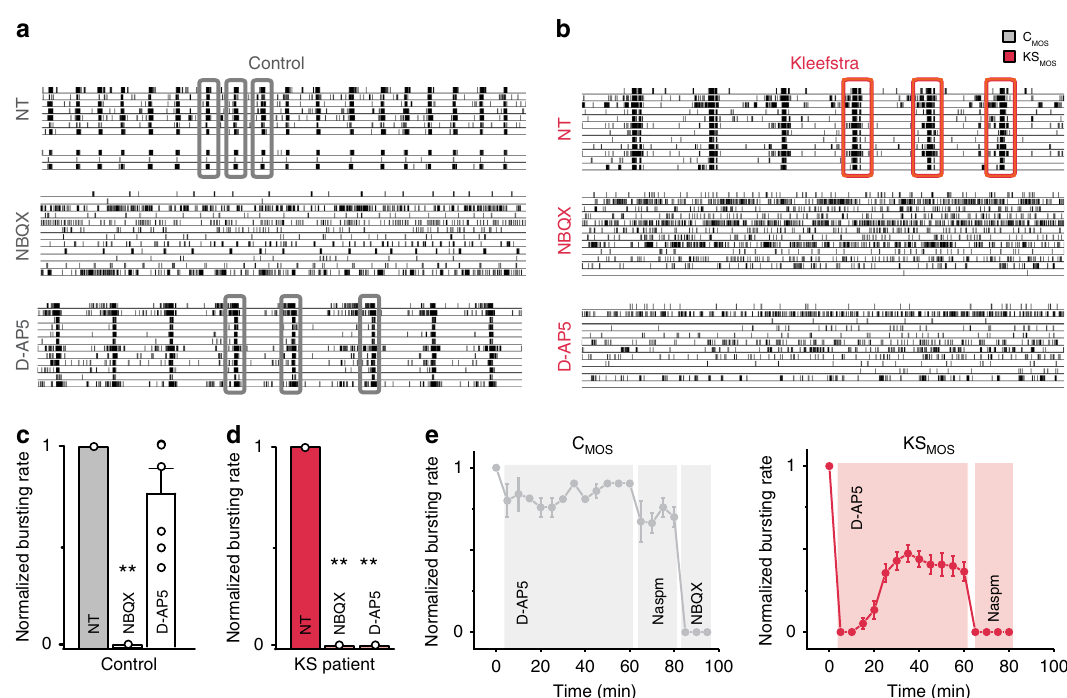
Fig. 4 Effect of AMPA- versus NMDA-receptor blockade on control and KS patient-derived neuronal network activity. a , b Representative raster plots showing 3 min of spontaneous activity from a control (C MOS ) and b KS (KS MOS ) neuronal networks grown on MEAs at DIV 28. Where indicated, the cells were either non-treated (NT) or treated with 50 µ M NBQX to block AMPA receptors or 60 µ M D-AP5 to block NMDA receptors. c , d Bar graphs showing the effect of NBQX and D-AP5 on the network burst rate for c control and d KS neuronal networks (C MOS and KS MOS respectively). The values are normalized to the NT data ( n = 6 for C MOS and n = 6 for KS MOS in all conditions). e The effect of a 1-hour D-AP5 treatment on C MOS and KS MOS neuronal network activity. After 1 h, the calcium-permeable AMPA receptor blocker Naspm (10 µ M) or NBQX were added. Data represent means ± SEM. ** P < 0.005, *** P < 0.0005, n = 8 for C MOS and n = 9 for KS MOS , one-way ANOVA test followed by a post hoc Bonferroni correction was performed between conditions. Source data is available as a Source Data fi